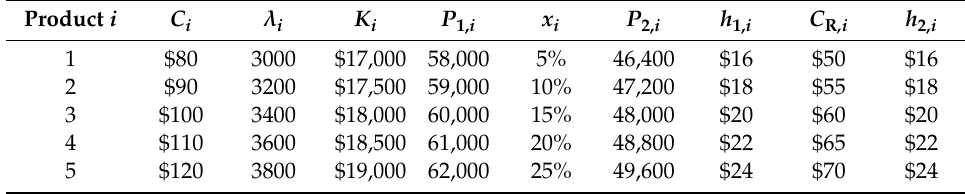
Table A1. Parameters’ values of the same problem using a single-stage